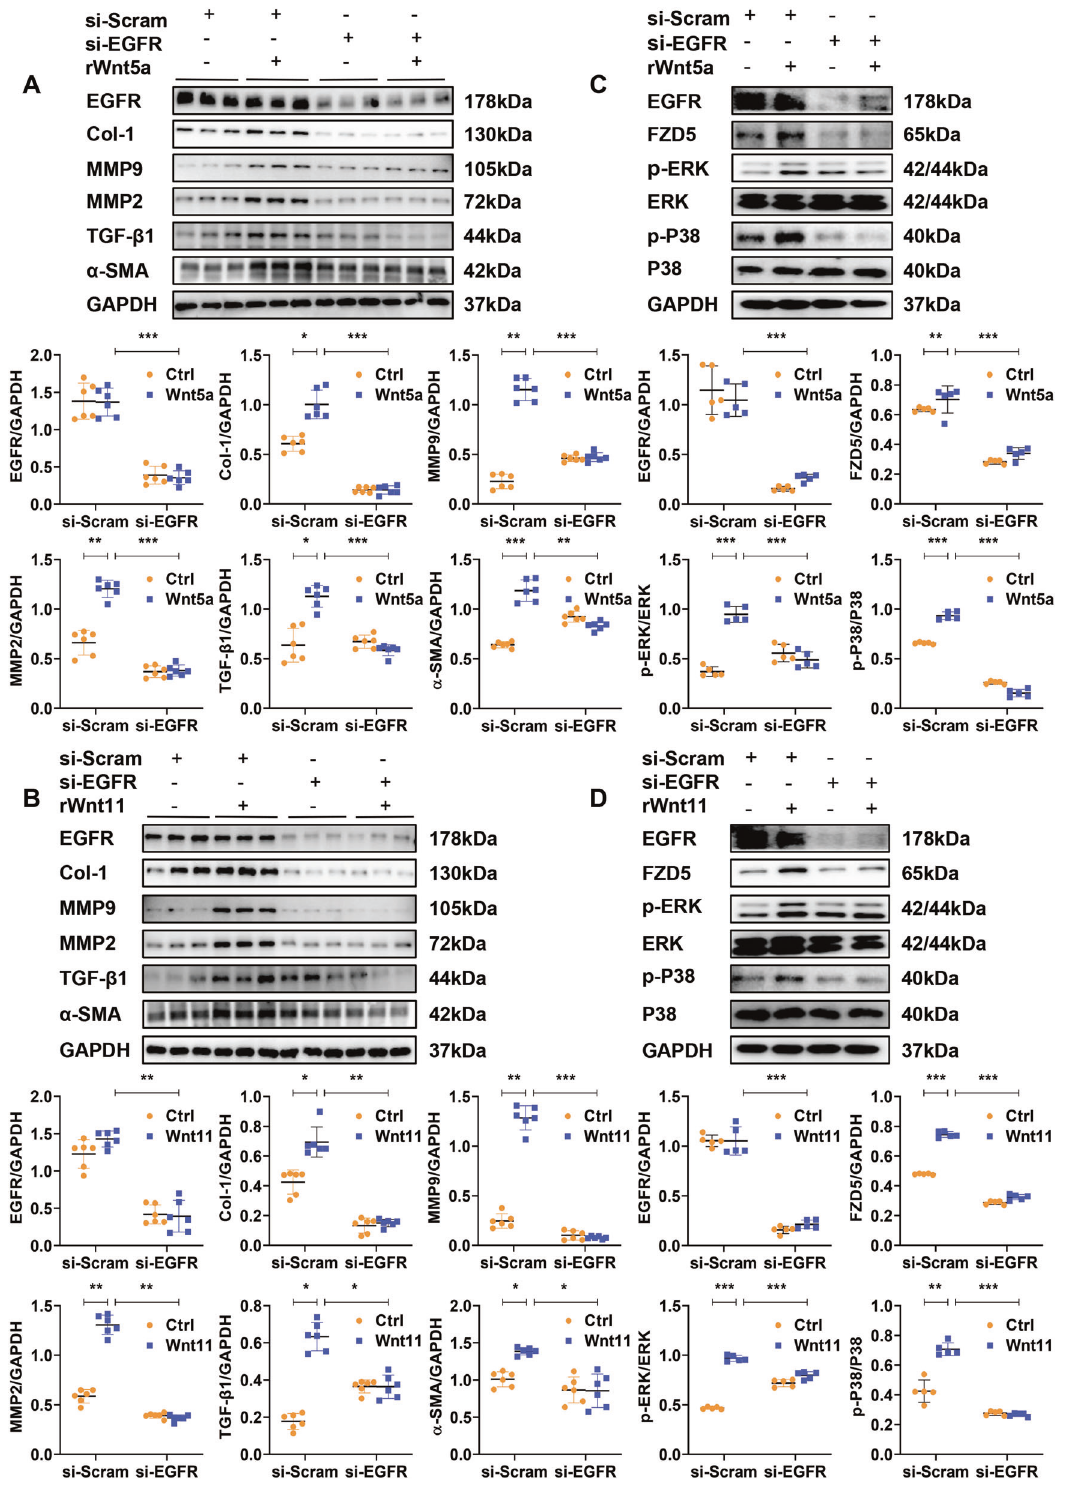
Fig. 7 Inhibition of EGFR activation attenuates the pro- fi brotic effect induced by Wnt5a or Wnt11 in neonatal rat cardiac fi broblasts. A , B The expression of EGFR, Col-1, α -SMA, MMP9, MMP2, and TGF- β 1 were detected by western blot in cardiac fi broblasts. After transfection with si-RNA-EGFR (si-EGFR) or si-RNA-scramble (si-Scram) for 48 h, these fi broblasts were treated with recombinant rat Wnt5a (rWnt5a) or Wnt11 (rWnt11) for 24 h, respectively. The same volume of PBS was treated as a control. n = 6/group. C , D The levels of p-ERK, p-P38, FZD5, and EGFR were examined by western blot analysis in cardiac fi broblasts. These fi broblasts were transfected with si-RNA-EGFR (si-EGFR) or si- RNA-scramble (si-Scram) for 48 h and then treated with recombinant rat Wnt5a (rWnt5a) or Wnt11 (rWnt11), respectively, 30 min later, these cells were analyzed. n = 5/group. All data were shown as mean ± SEM; * P < 0.05, ** P < 0.01, *** P <